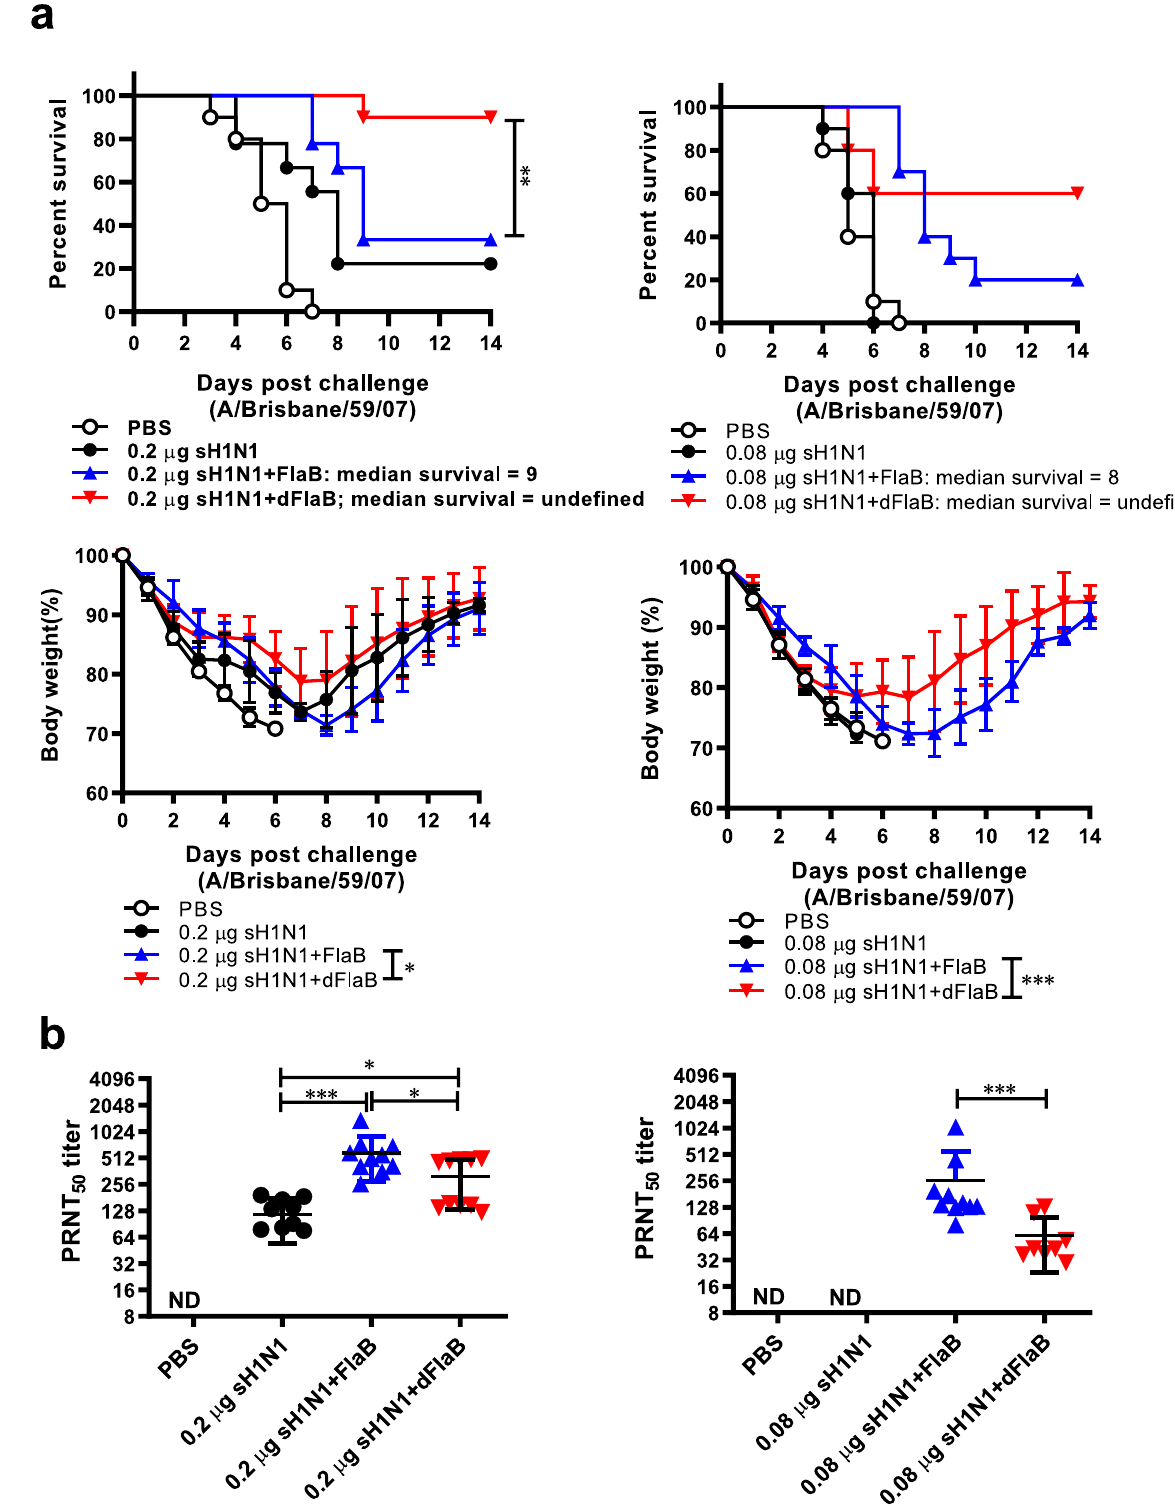
Fig. 6 The dFlaB-adjuvant induced better protection than that of wild type FlaB in a H1N1 in fl uenza lethal challenge model. Groups of mice ( n = 9 – 10) were intranasally immunized with PBS, FlaB, dFlaB, H1N1 A/Brisbane/59/07 split vaccine (sH1N1), sH1N1 plus FlaB (sH1N1 + FlaB), or sH1N1 plus dFlaB (sH1N1 + dFlaB) three times at a two-week interval. Two weeks after the immunization, mice were intranasally challenged with a 2.4 × LD 50 live A/Brisbane/59/07 in fl uenza virus. After the challenge, survival rate and changes in body weight ( a ) were monitored for 2 weeks. Naive mice were used as controls for the determination of body weight change. b Plaque reduction neutralization test (PRNT) using live in fl uenza A/Brisbane/59/07 virus. Two weeks after the last immunization, serum was collected from the retroorbital plexus. PRNT 50 titer was determined as 50% neutralization of plaques based on positive control virus wells. Mann – Whitney test was used to compare two